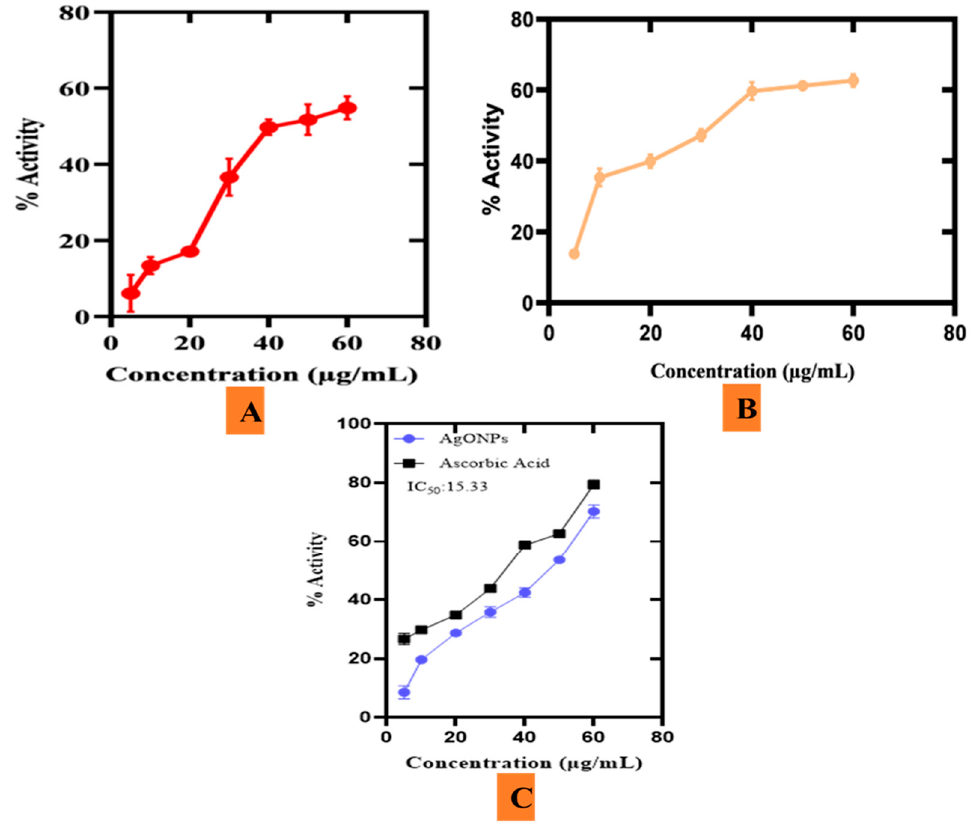
Figure 15. ( A ) Antioxidant (TAC) potential of P . alsinaefolia -Ag 2 ONPs. ( B ) Antioxidant (TRP) potential of P . alsinaefolia -Ag 2 ONPs. ( C ) Antioxidant (DPPH) potential of PA-Ag 2 ONPs.